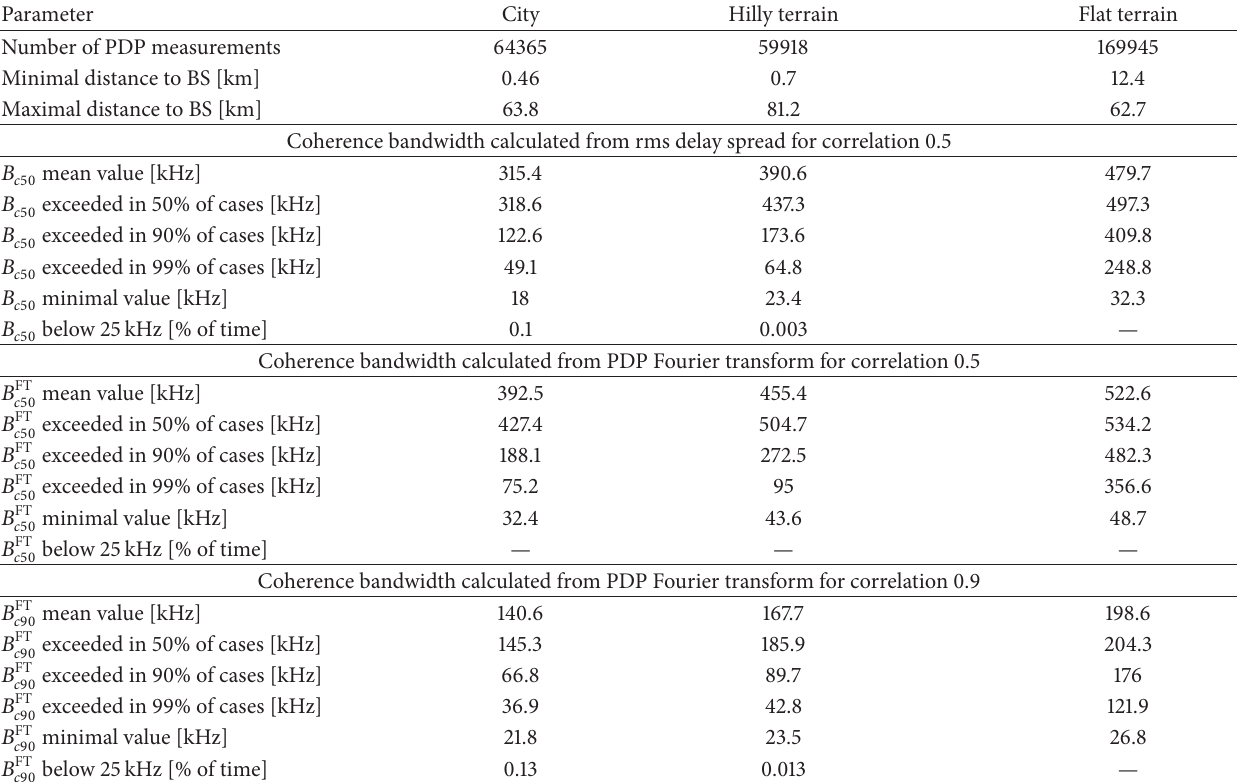
Table 3: Measured values of coherence bandwidth for UHF narrowband